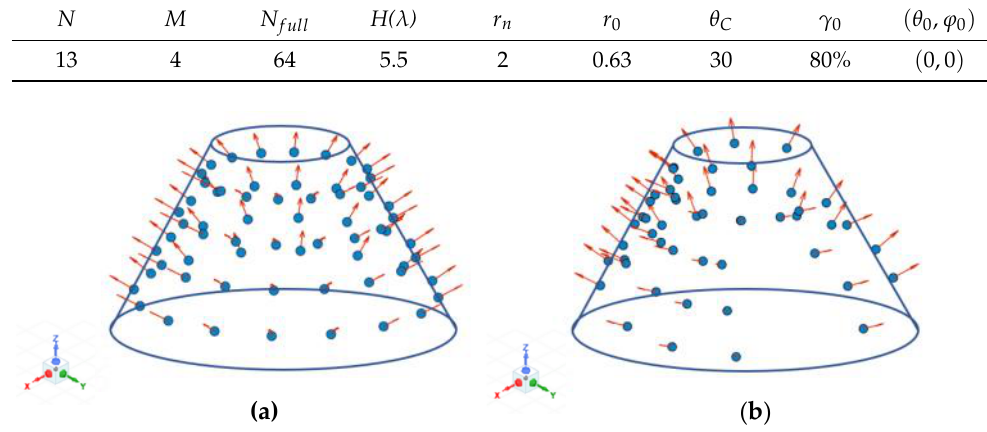
Figure 6. The geometry of the full array and sparse array. ( a ) Full array. ( b ) Sparse array.